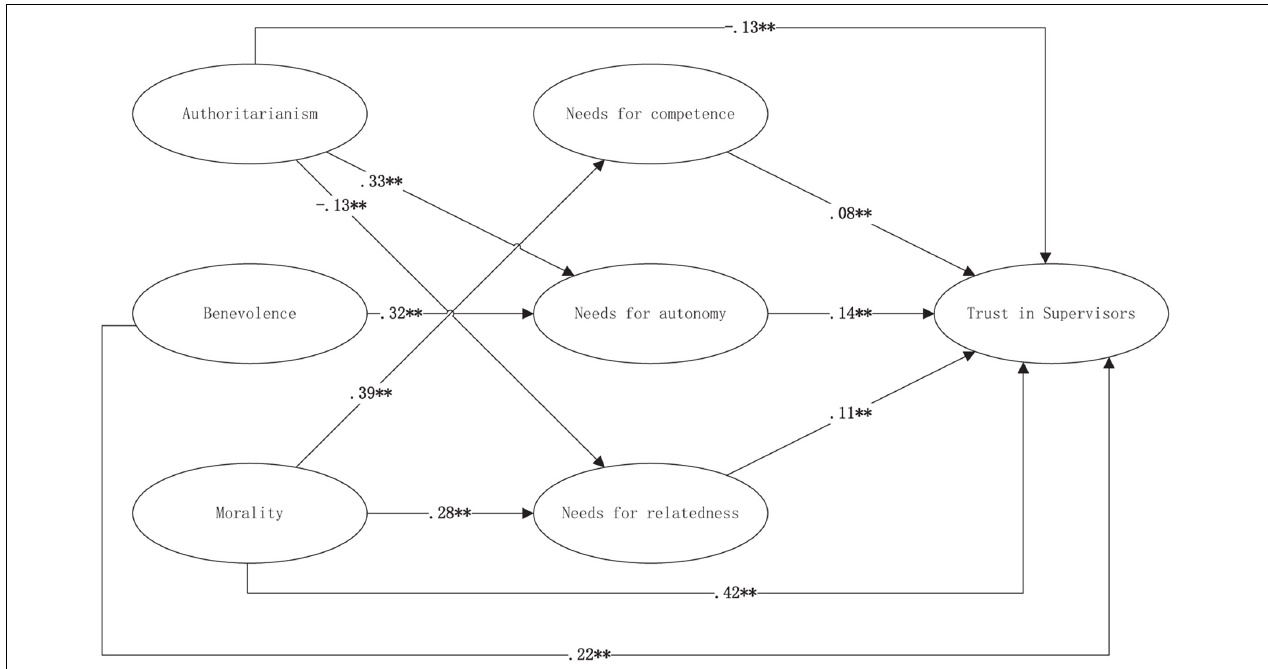
FIGURE 2 | Standardized results of the research model. Non-significant paths are not shown in this figure; ∗ p < 0.05 and ∗∗ p <